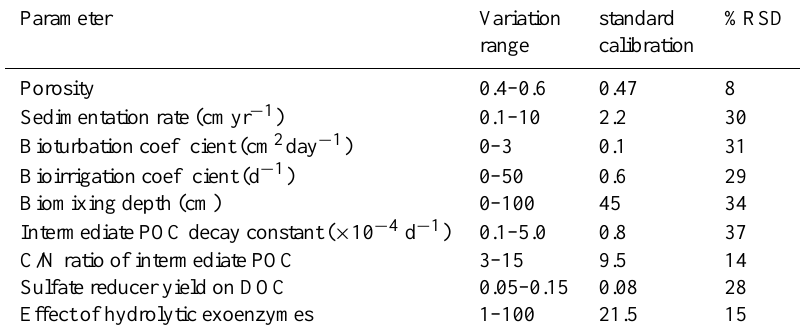
Table 1. Monte Carlo parameter variation: Parameter ranges, standard calibration (Fig. 6), and relative standard deviation (%RSD) of parameters from 145 calibrations with average %RSD < 5% with respect to SO 4 and NH 4 (Fig.